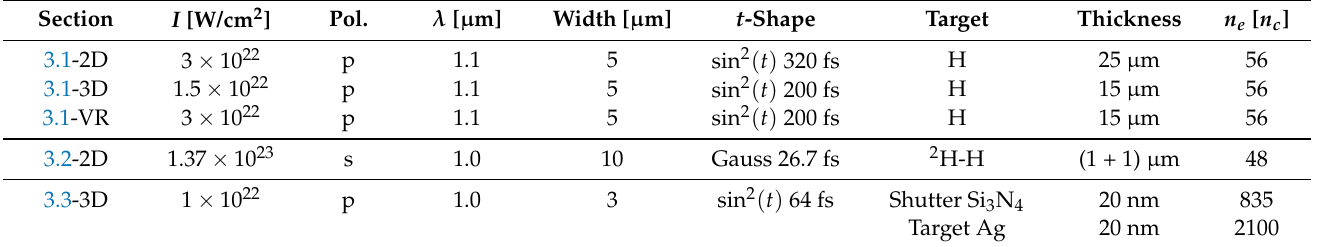
Table 1. The main laser–target simulation parameters. In order: Intensity I , polarization, wavelength λ , width of Gaussian space profile at FWHM, temporal shape-duration for sin 2 ( t ) and FWHM for Gaussian, target material, thickness, and electron density n e in the corresponding critical density n c